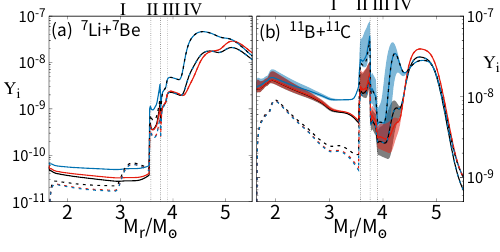
Figure 1. The calculated abundances of (a) 7 Li + 7 Be and (b) 11 B + 11 C as a function of Lagrangian mass coordinate in units of M ⊙ . Red and blue lines correspond to inverted and normal hierarchies, respectively. Colored bands reflect the uncertainty of the 11 C( α, p ) 14 N reaction rate. Solid and dashed lines are the results using Suzuki et al. [10] and Ho ff man & Woosley [11] rates for 16 O + ν ,